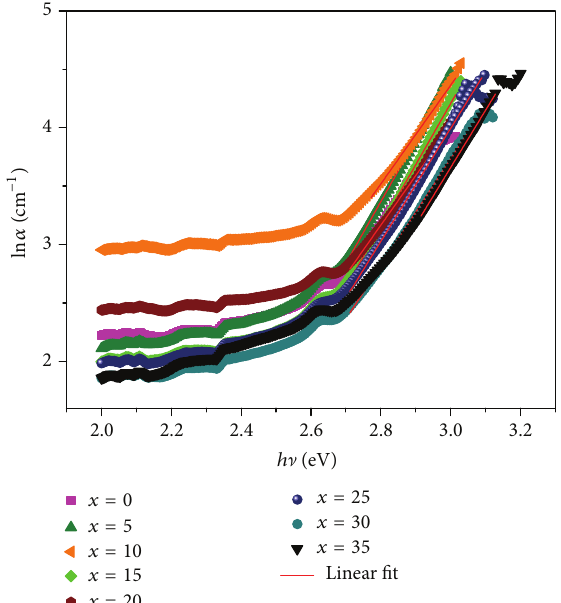
Figure 4: ln 𝛼 plotted against photon energy, ℎ ] , for 40SiO 2 ⋅ 𝑥 ZnO ⋅ ( 60 − 𝑥 )Bi 2 O 3 glass